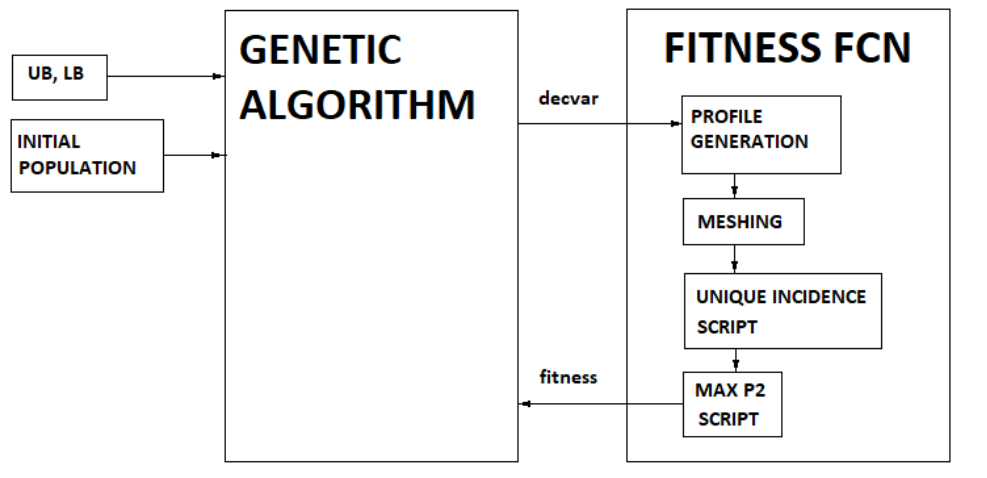
Figure 6. Scheme of the optimization